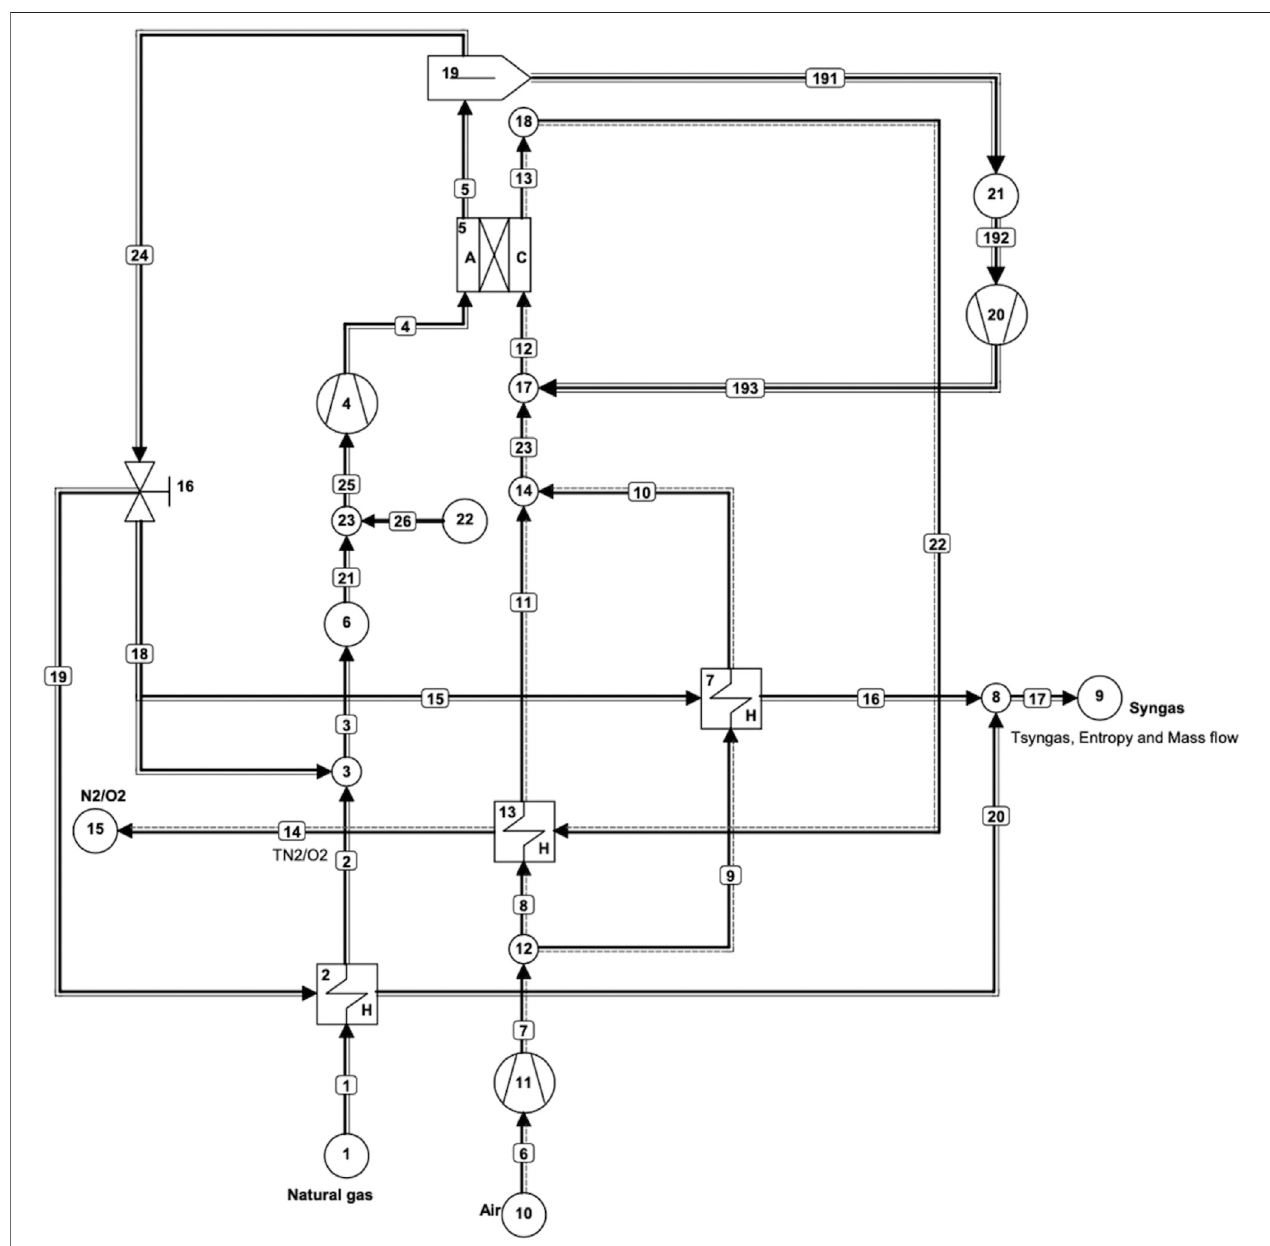
FIGURE 1 | Cycle-Tempo fl owsheet diagram of an internal reforming MCFC system for coproduction of hydrogen and power.